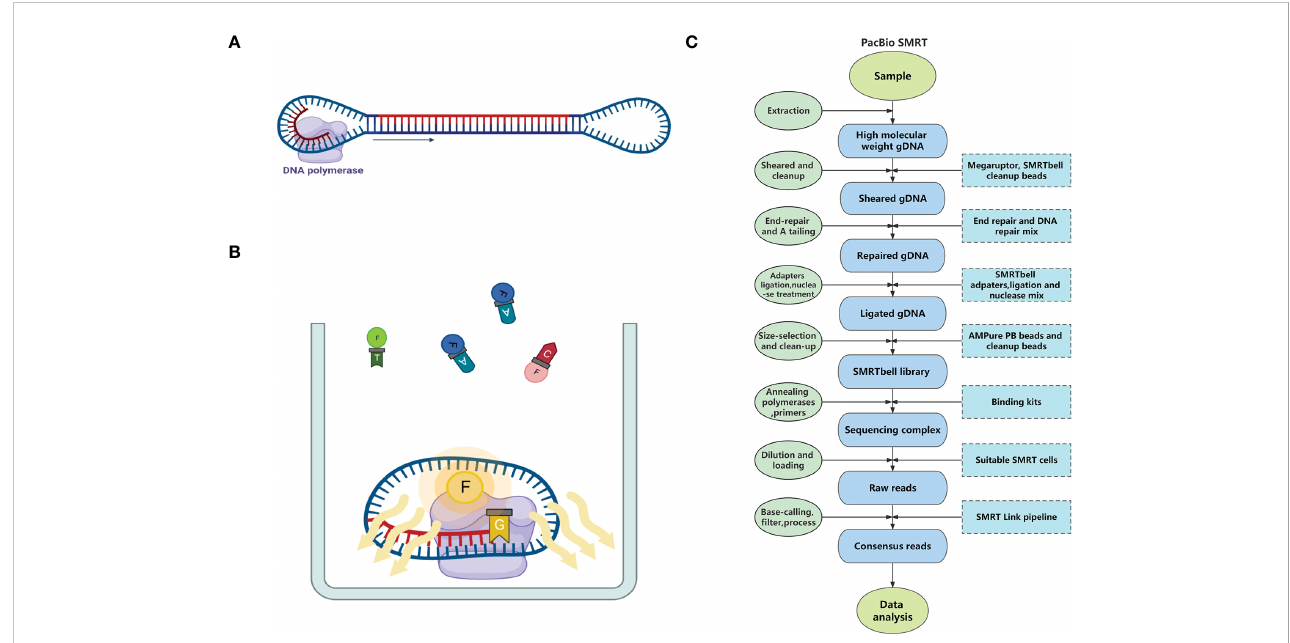
FIGURE 1 The principle and pipeline of PacBio SMRT Technology. (A) A dumbbell-shaped template for sequencing (SMRTbell) consists of adapters in both ends, a double-stranded DNA template, and a DNA polymerase. (B) The process of sequencing in the Zero-model waveguide (ZMW). (C) The pipeline of PacBio SMRT